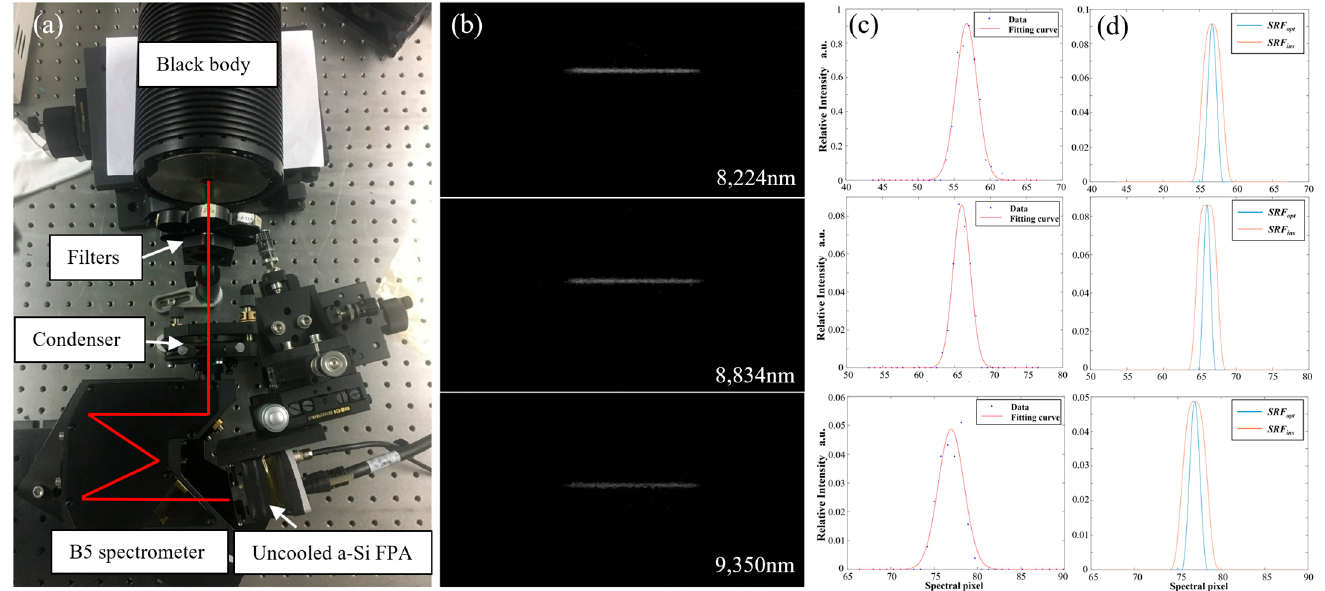
Figure 22. ( a ) Test device for B5 spectrometer, ( b ) spectral lines, ( c ) SRFs containing filter bandwidth, ( d ) SRF opt and SRF ins of B5 spectrometer. Table 7. Spectral resolution of B5 spectrometer with 3× pixels binning FWHM of SRF at Different Fields/nm Wavelength/nm − 1 Field